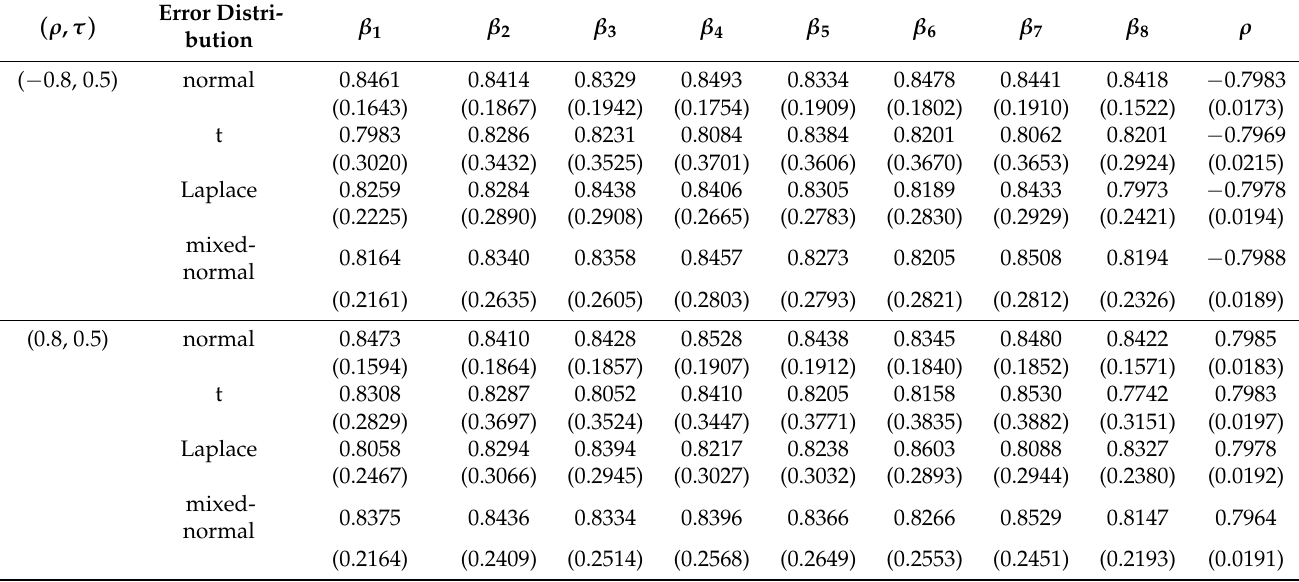
Table A1. Means and RMSEs (in parentheses) in the simulation study of Appendix